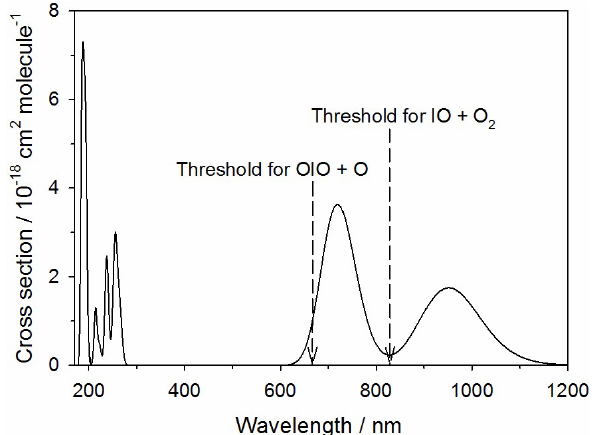
Figure 11. Absorption spectrum of IO 3 calculated at the TD/B3LYP/gen level of theory (see text for further details). The arrows indicate the energy thresholds for the two photodissociation pathways.